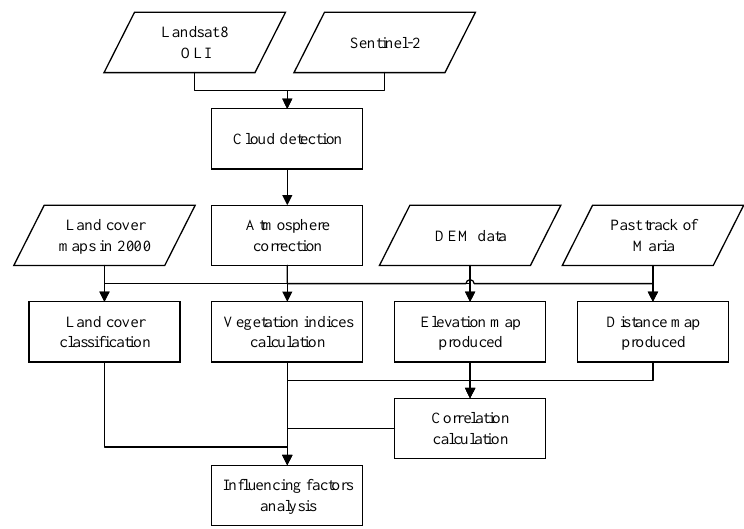
Figure 2. The flowchart for analyzing influencing factors of Hurricane Maria.